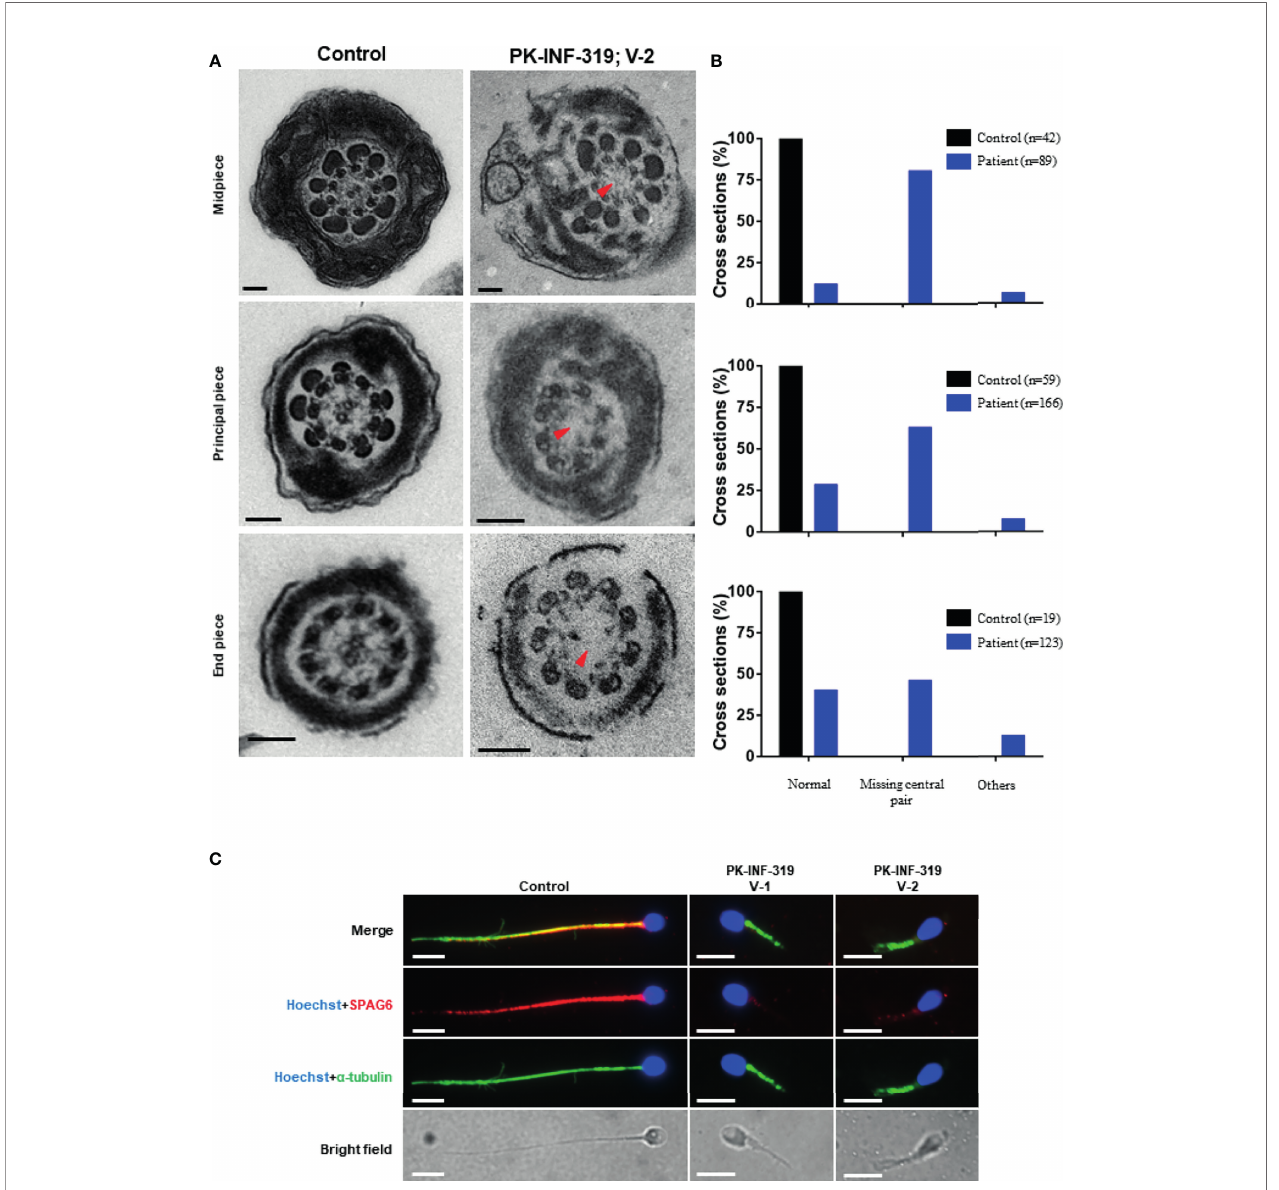
FIGURE 2 | Transmission electron microscopic investigation of spermatozoa from patients and healthy control. (A) The cross-section of a healthy control spermatozoa represented an intact axoneme structure comprised of doublets of microtubules, circularly arranged around a central pair complex of microtubules (nine + two organization), surrounded by outer dense fi bers and fi brous sheath. The cross-section of a patient spermatozoa displayed a missing central singlet of microtubules and disorganized fi brous sheath. Scale bars, 500 um. (B) Graphs representing the cross-sections of microtubule doublets corresponding to midpiece, principal piece, and end piece were statistically analyzed in control and patient. (C) The patient spermatozoa were devoid of SPAG6 signals (marker to check the integration of microtubules of the central pair), indicating disruption of inner dynein arm, while well-decorated SPAG6 signals were observed on the tail of spermatozoa obtained from a healthy control. Scale bars, 10